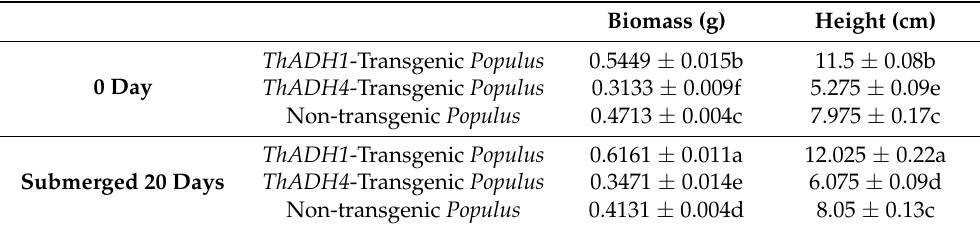
Table 3. Growth parameters of transgenic Populus and Non-transgenic Populus at 0d and 20d of flooding